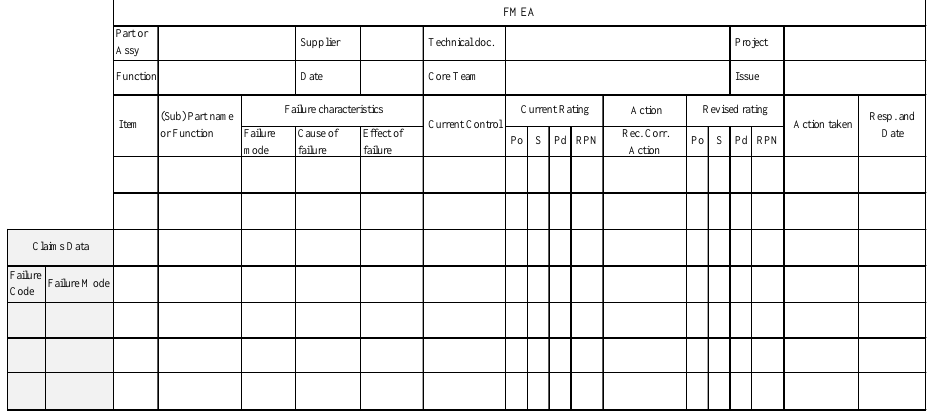
Table 1 – FMEA Template as per the practice at the organization